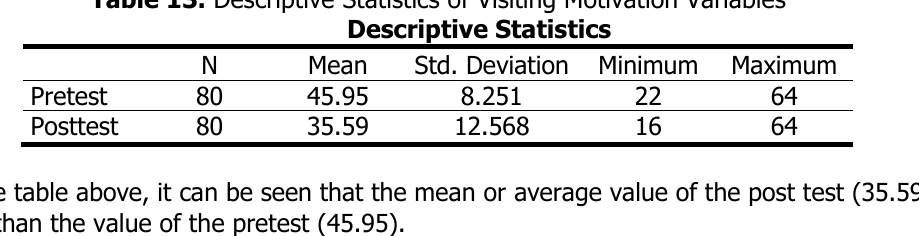
Table 13. Descriptive Statistics of Visiting Motivation Variables